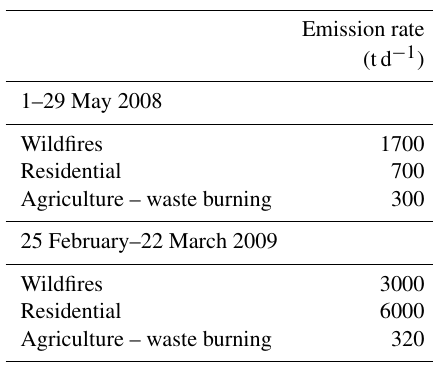
Table 2. Organic compound emission rates (in td − 1 ) over the mod- eling domain during the simulated periods.